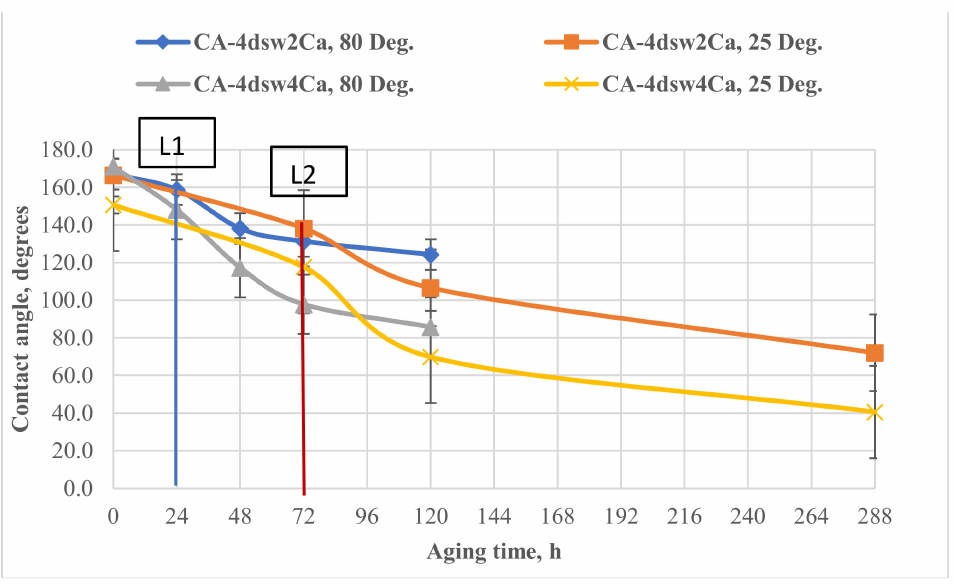
Figure 11. Effect of active ions (Ca 2+ ) on the performance of EW and EW-NF, at room temperature and an elevated temperature of 80 ◦